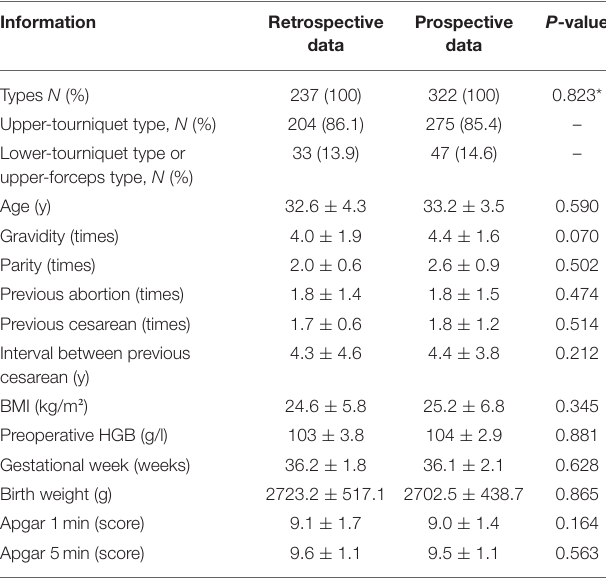
TABLE 1 | General characteristics of cases in retrospective and prospective analyses.